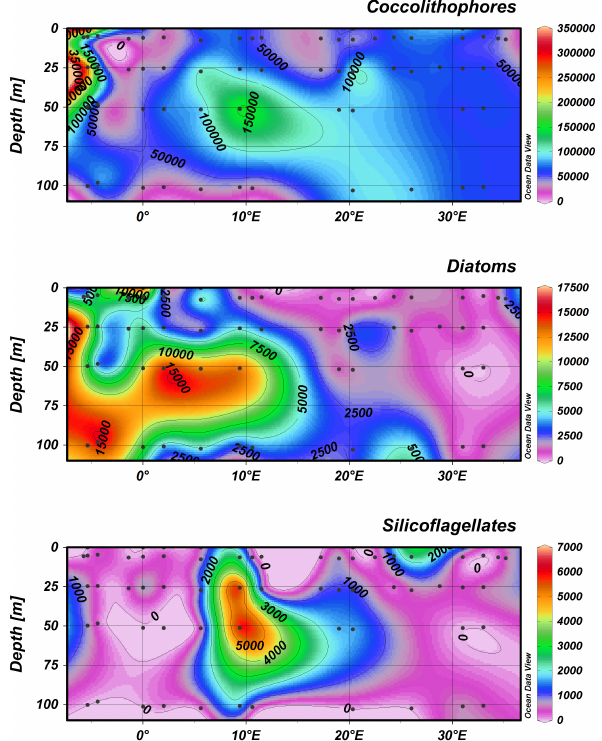
Figure 4. Distribution of coccolithophores (upper panel), diatoms (middle panel) and silicoflagellates (lower panel) in a west–east transect along the Mediterranean Sea (the transect includes the stations labeled in black in Figure 1).